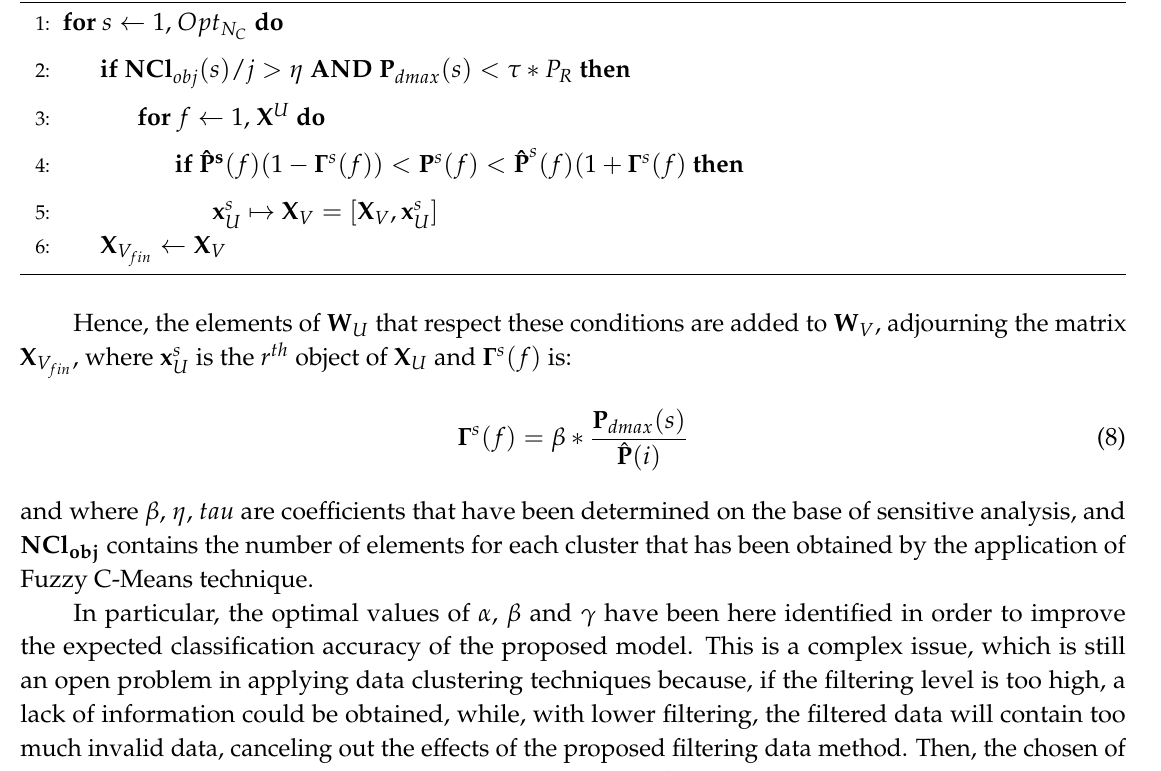
Algorithm 3 Adding x U